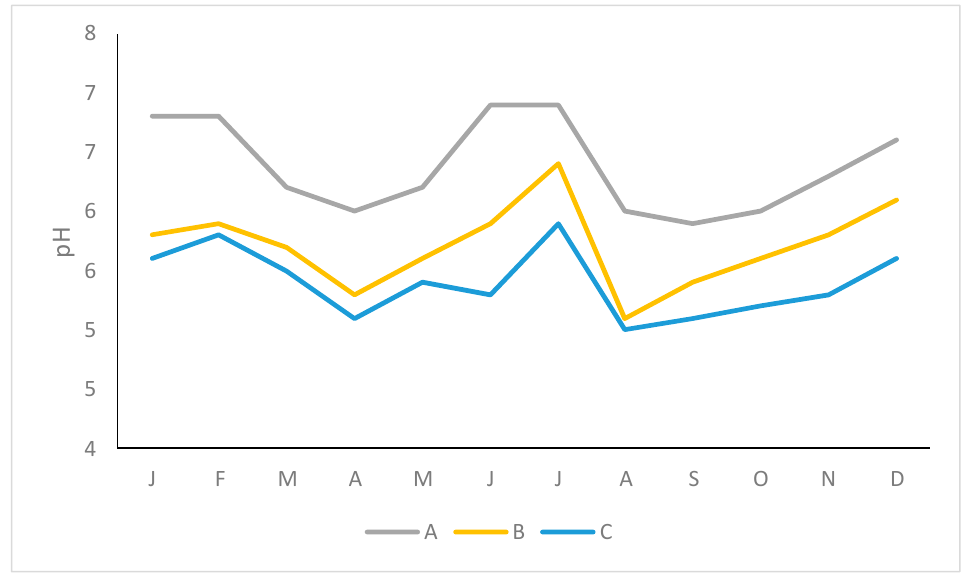
Figure 7. Temporal variability of pH. A: rural area, B: poor community, C: rich neighbourhood.